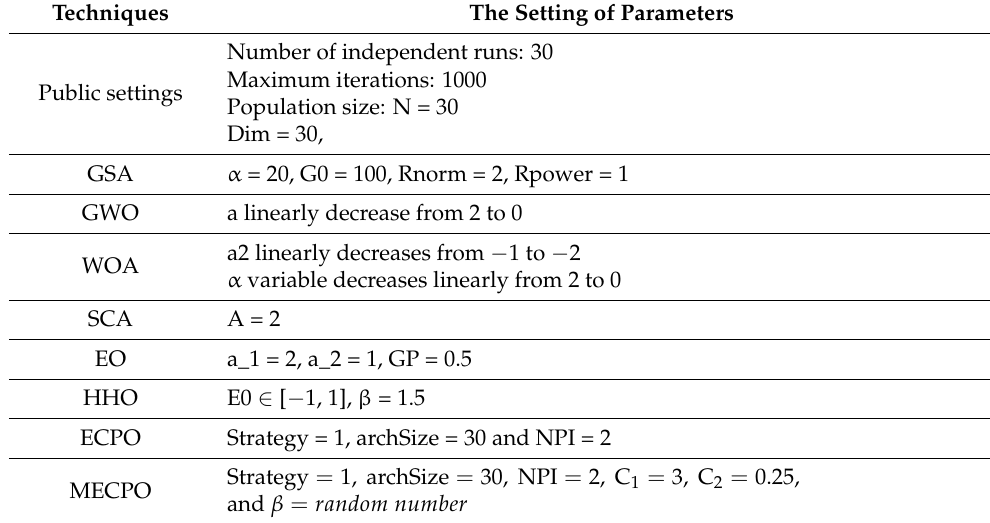
Table 2. The settings of the parameter for the MECPO technique and the counterparts. Techniques